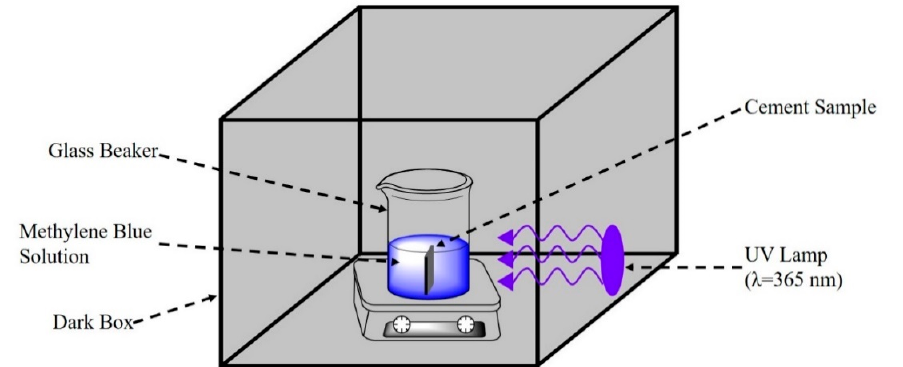
Figure 3. Schematic diagram of the photocatalytic test.